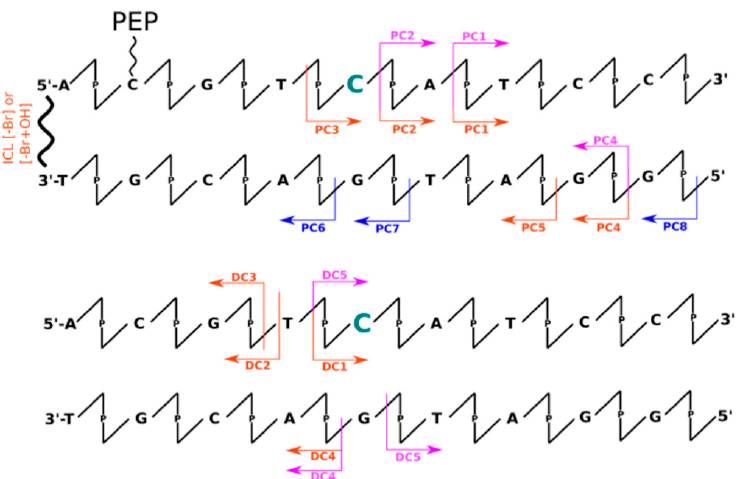
Figure 2. Schematic representation of all identified oligonucleotides’ fragments by means of LC-MS for BrdC labeled systems (upper with peptide conjugate, lower without peptide conjugation). The scheme represents only part of the dsDNA structure. The arrows represent the respective fragments identified for X-ray radiation experiments (blue), UV irradiation by 320 nm photons (pink), and 280 nm photons (orange). Modified nucleobase was pointed in green. Below the arrows the names of identified fragments are listed starting with “P” stands for system with peptide conjugation, starting with “D” without peptide conjugation. Additionally, the interstrands cross-links (ICL) were observed. For possible mechanisms please see Figures S7–S11.